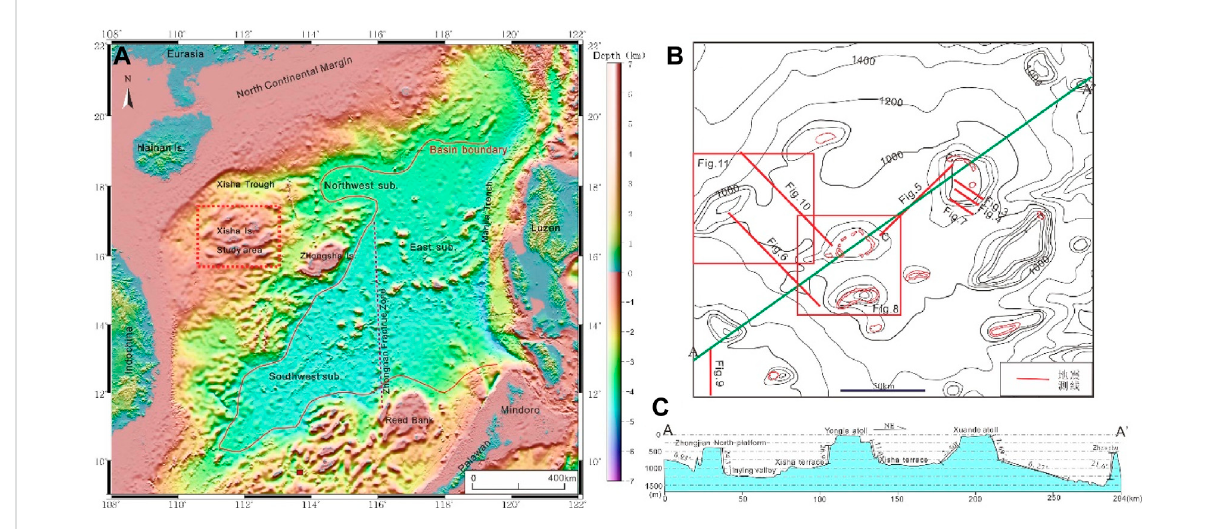
FIGURE 1 (A) Location map of the study area, modi fi ed from Cao et al. (2017). (B) Location map of seismic survey line used in the text. (C) Water depth pro fi le of AA ’